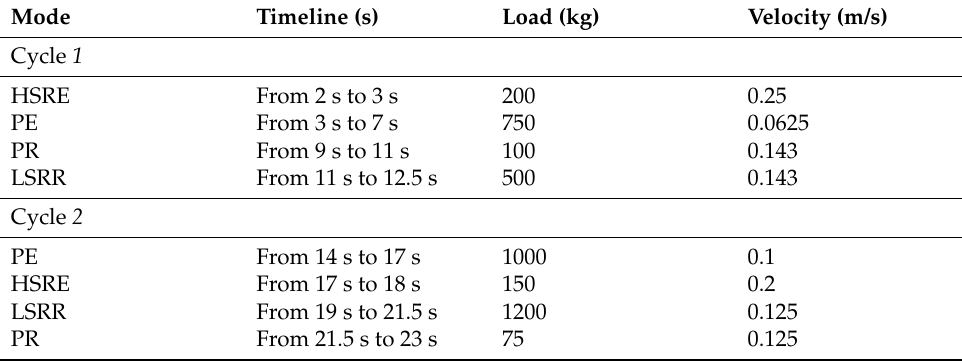
Figure 14. The energy consumption in both control methods. Table 7. Switching mode over two cycles of the NIVM